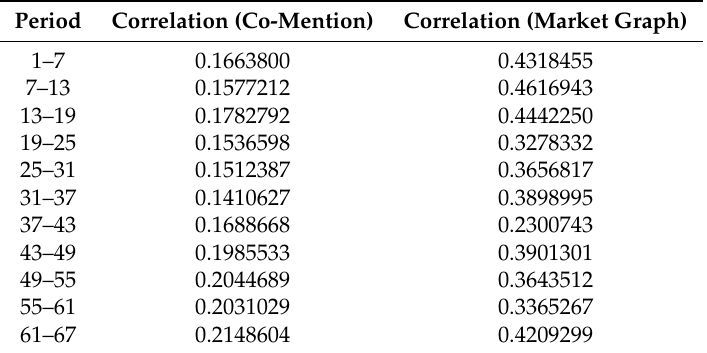
Table 5. QAP Correlation